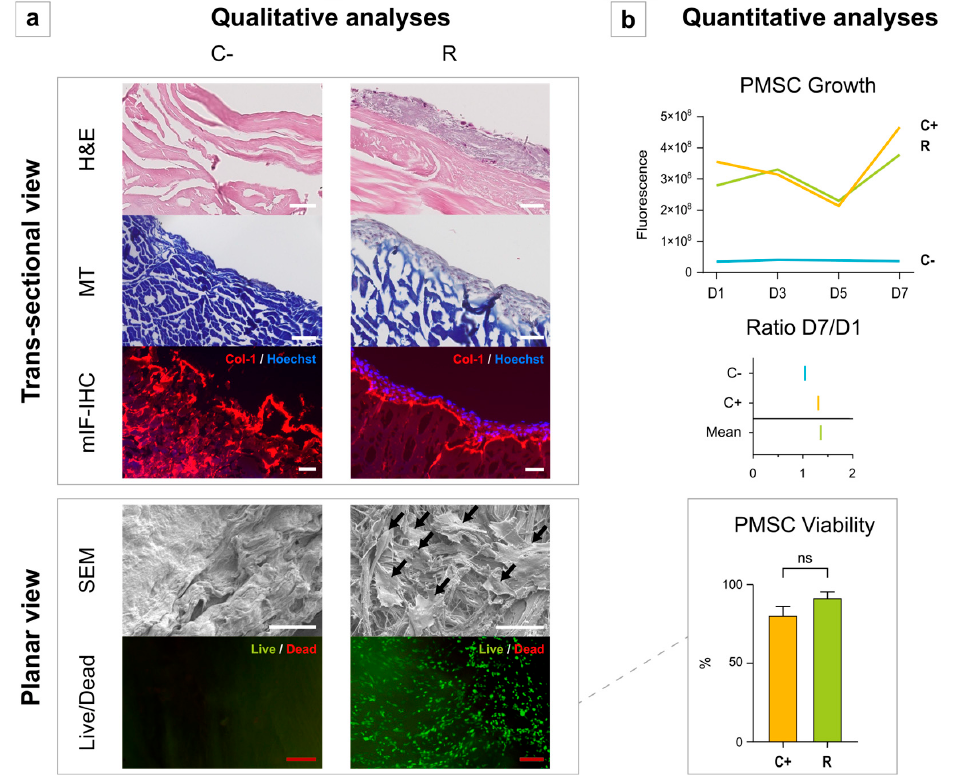
Figure 3. Qualitative ( a ) and quantitative ( b ) evaluation of D-HFL scaffold recellularization with PMSCs. The PMSC growth was assessed using the PrestoBlue Assay (PrestoBlue™ Cell Viability Reagent, ThermoFisher, Invitrogen, A13261, Waltham, MA, USA) on days (D) 1, 3, 5, and 7. The ratio D7/D1 expresses the ratio of the number of cells on D7 to that on D1. The Live/Dead staining (LIVE/DEAD™ Viability/Cytotoxicity Kit, ThermoFisher, Invitrogen, L3224, Waltham, MA, USA) evaluated the cell viability by the ratio between the number of living cells and the total number of cells on the patch. C-: negative control (scaffold without cells), R: recellularized scaffold, C+: positive control (cells without scaffold), H&E: hematoxylin and eosin, MT: Masson’s trichrome, mIF-IHC: multiplex immunofluorescence immunohistochemistry, Col-1: type-1 collagen, SEM: scanning elec- tron microscopy, and Dx: day number x. Black arrows show seeded PMSCs. White scale bars: 50 μ m. Red scale bars: 200 μ m. ns: non-significant.